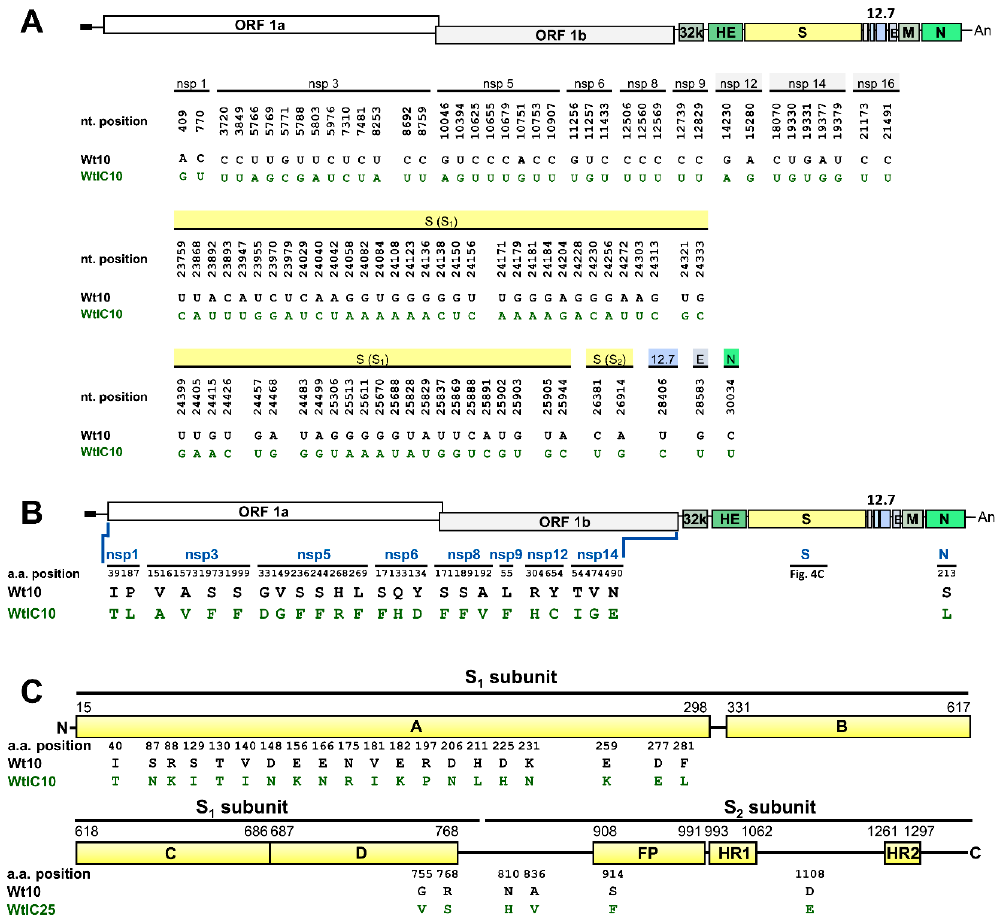
Figure 4. Linear schematic of BCoV genome showing the location of mutated nt and aa caused by poly IC-induced innate immunity in HRT-18 cells. ( A ) Linear schematic of BCoV genome showing the comparison of the nt sequences identified from HRT-18 cells infected with wt BCoV (Wt) in the presence (WtIC10) or absence (Wt10) of poly IC at VP10. ( B ) Linear schematic of BCoV genome showing the comparison of the aa sequences identified from HRT-18 cells infected with Wt in the presence (WtIC10) or absence (Wt10) of poly IC at VP10. ( C ) Linear schematic of BCoV S protein with subunits S1 (domains A–D) and S2 (FP, HR1, and HR2) showing the positions of the aa alterations identified from HRT-18 cells infected with Wt in the presence (WtIC10) or absence (Wt10) of poly IC at VP10. ORF: open reading frame, 32K: 32 kDa protein, HE: hemagglutinin / esterase, S: spike protein, 12.7: 12.7 kDa protein, E: envelope protein, M: membrane protein, N: nucleocapsid protein, FP: fusion peptide, HR1: heptad repeat 1, HR2: heptad repeat 2.